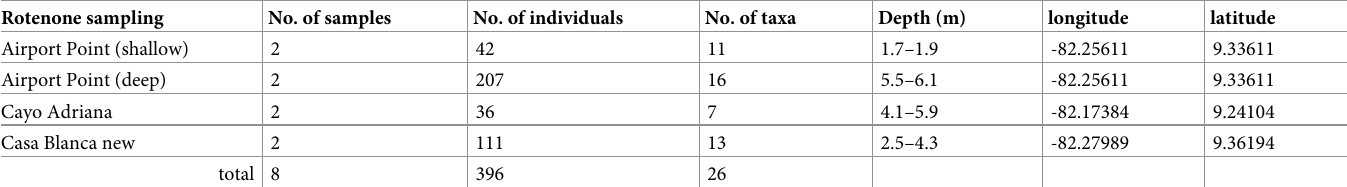
Table 2. Location and general information of rotenone sampling sites. Rotenone